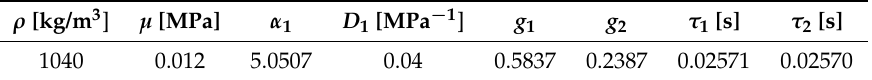
Table 3. Brain material